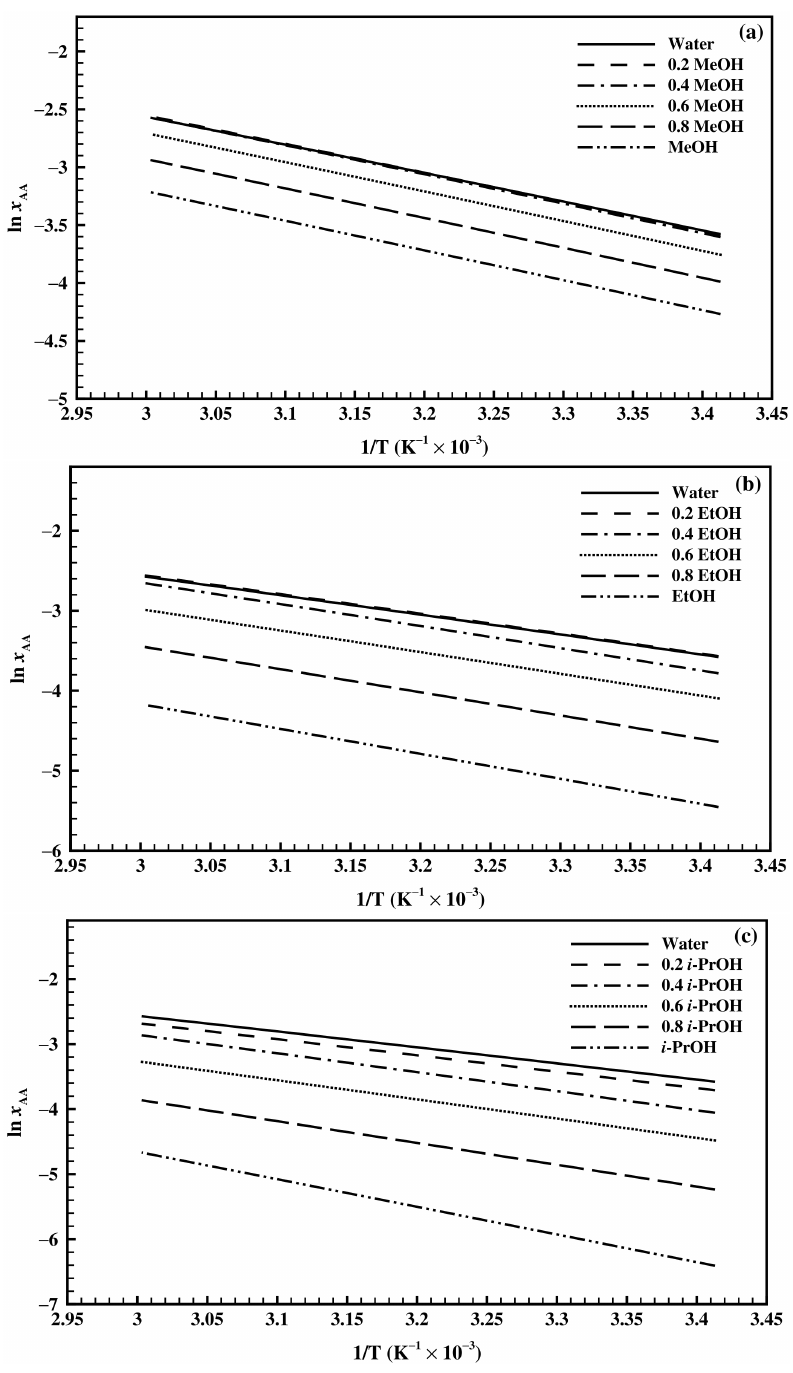
Figure 6. Van’t Hoff plot for ( a ) Water-Methanol, ( b ) Water-Ethanol and ( c )